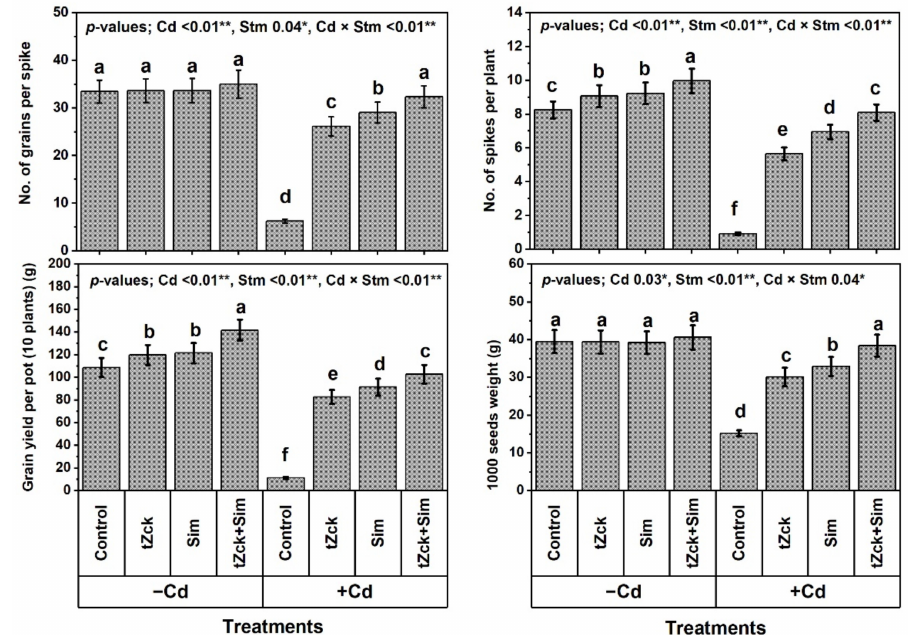
Figure 2. Yield traits of wheat (cv. Sakha 93) treated with two stimulators (Stm) i.e., silymarin (Sim; 0.5 mM) and trans -zeatin-type cytokinin ( t Zck; 0.05 mM) under cadmium (Cd; 0.6 mM) stress. The same letters with mean values ± SE in each plot indicate non-significant differences based on the LSD test ( p ≤ 0.05). * and ** refer to significant difference at p ≤ 0.05 and p ≤ 0.01, respectively. t Zck; trans -zeatin-type cytokinin, Sim; silymarin, − Cd; without cadmium treatment, +Cd; cadmium treatment and Stm;